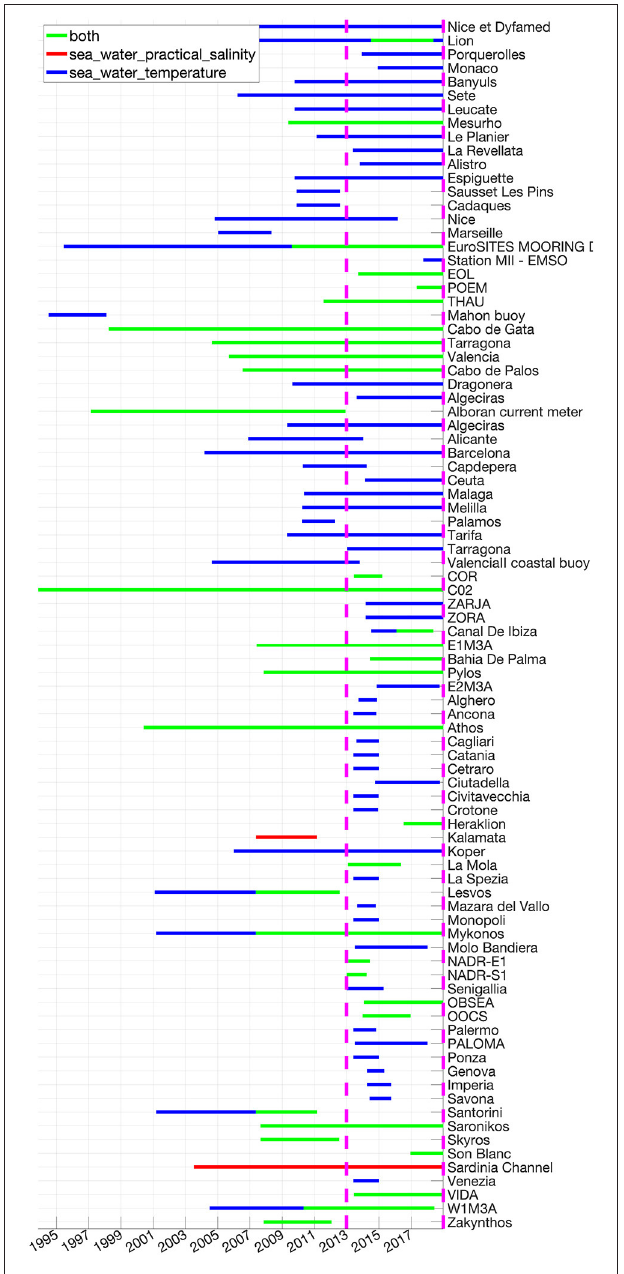
FIGURE 2 | Time coverage of each MED-NRT mooring time series having temperature and/or salinity measurements. Only time series longer than 1 year are displayed. Purple lines indicate the time range considered for successive Cal/Val